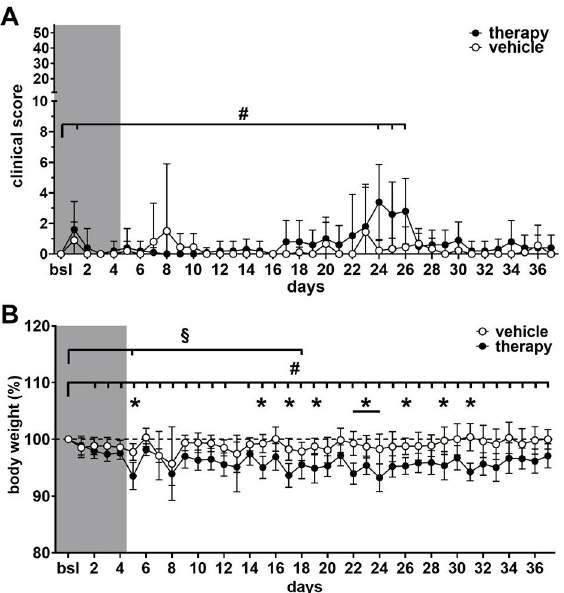
Fig 4. Assessment of clinical score and body weight during chemotherapy and respective vehicle application. Clinical scores and body weight were assessed in therapy (n = 10) and vehicle group (n = 9–10). (A) The course of the clinical score showed slight, although significant increases in the therapy group compared to baseline (#; Wilcoxon signed-rank test, p < 0.05) and nodifferences between groups. (B) Body weight was reduced in the therapy group during all but one days in the treatment phase compared to baseline levels (# = therapy group: linear mixed-effects model, fixed effects type III: p < 0.0001, F (6.136, 55.22) = 9.780 with Dunnett’s multiple comparisons test, p < 0.05). Body weight in the vehicle group was significantly reduced merely on day 5 and 18 (B; § = vehicle group: linear mixed- effects model, fixed effects type III: p = 0.0528, F (3.429, 28,08) = 2.785 with Dunnett’s multiple comparisons test p < 0.05). Between therapy and vehicle group significant differences in body weight were detected on several days (B; � )(linear mixed-effects model, fixed effects (type III) for group: p = 0.0041, F (1, 18) = 10.83 with Bonferroni‘s multiple comparisons test p <